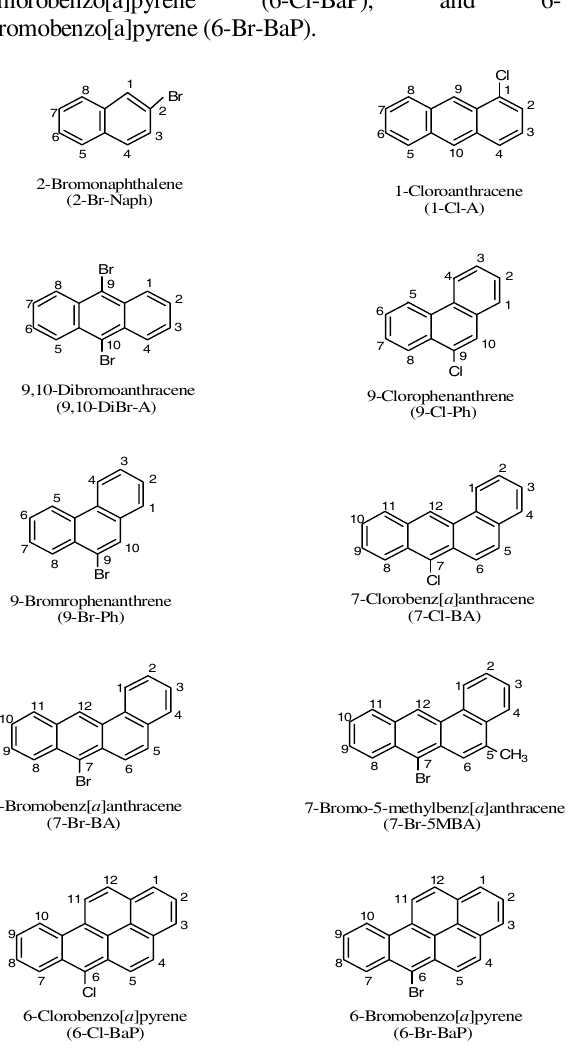
Figure 1: Names and structures of the halo-PAHs used for